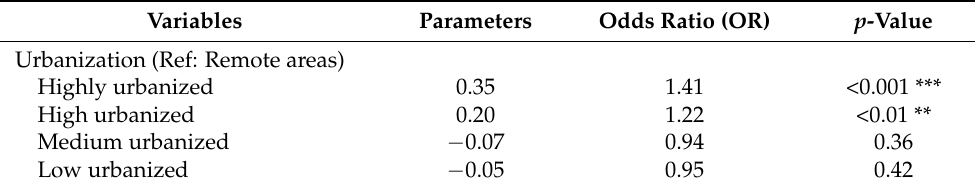
Table 4. Urbanization and Incidence of Cataract (N =